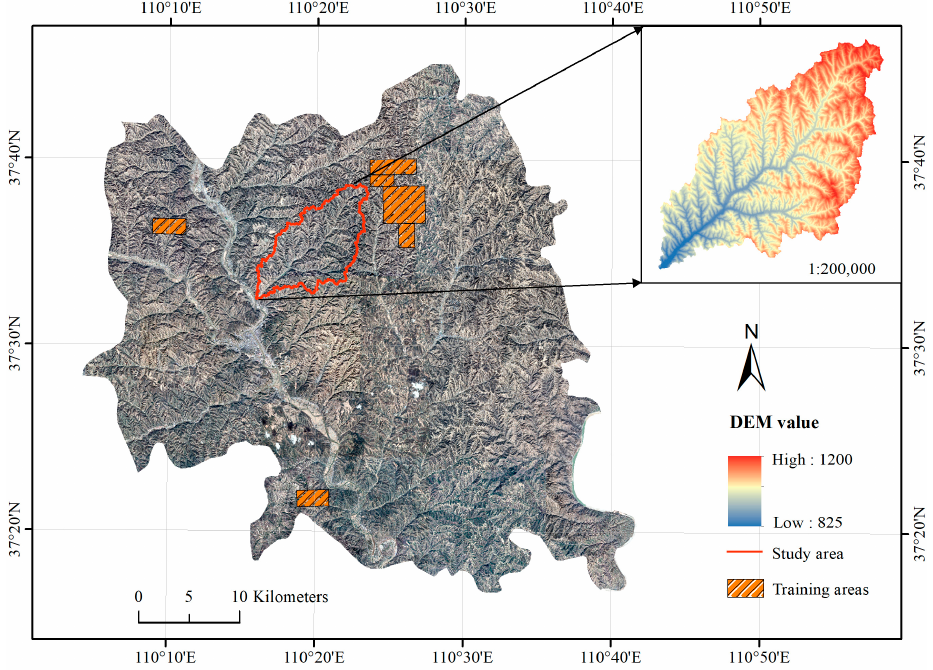
Figure 2. The location of the study